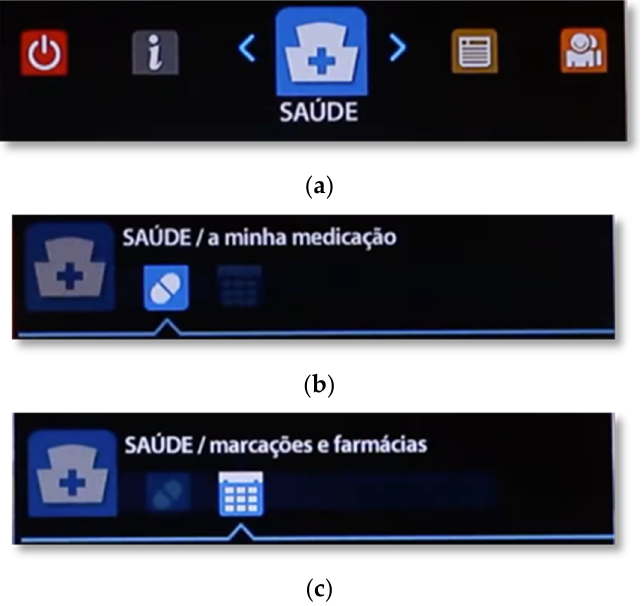
Figure 4. Breakdown of the main menu into areas and their tabs: ( a ) Menu—Health area. ( b ) Health area—“my medication” page. ( c ) Health area—“appointments and pharmacies” page.